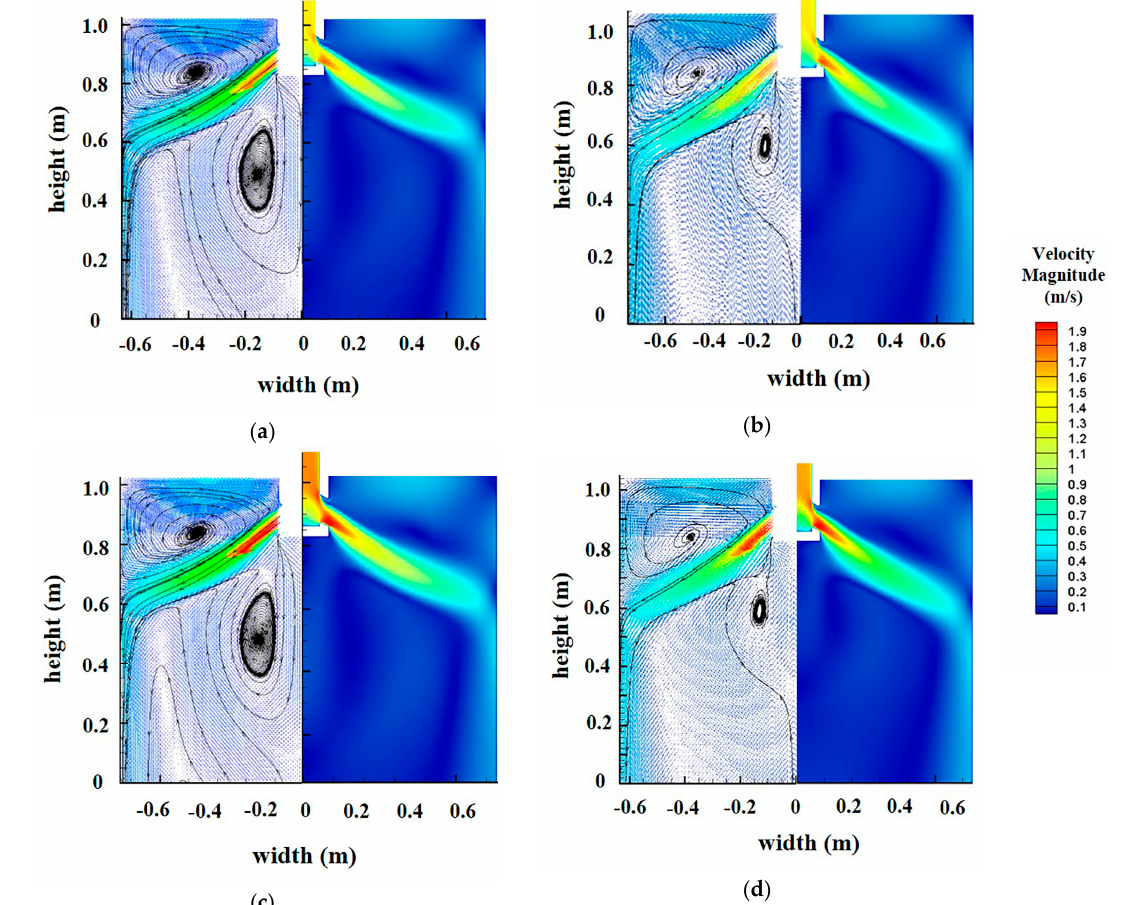
Figure 5. Contour and vector of velocity at wide face in mold: ( a ) casting speed 1.6 m / min, submerged depth 70 mm; ( b ) casting speed 1.8 m / min, submerged depth 70 mm; ( c ) casting speed 1.6 m / min, submerged depth 90 mm; ( d ) casting speed 1.8 m / min, submerged depth 90